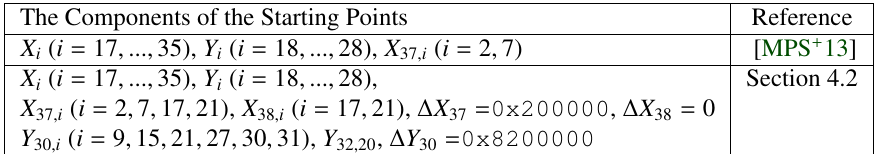
Table 4: The Comparison of the Components of the Starting Points The Components of the Starting